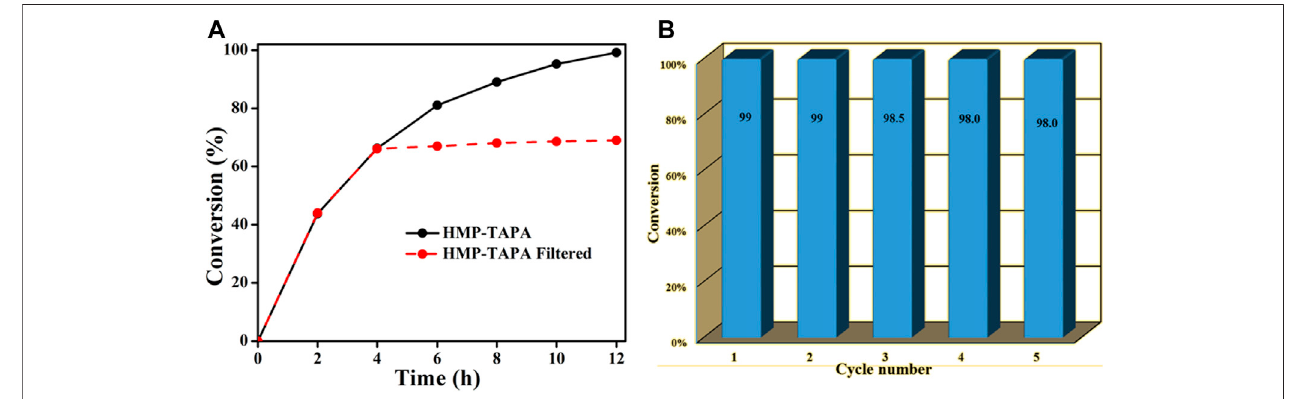
FIGURE 7 | (A) Leaching test for the HMP-TAPA catalyst removed after 4 h. (B) Recycling test of HMP-TAPA for fi ve successive cycles.